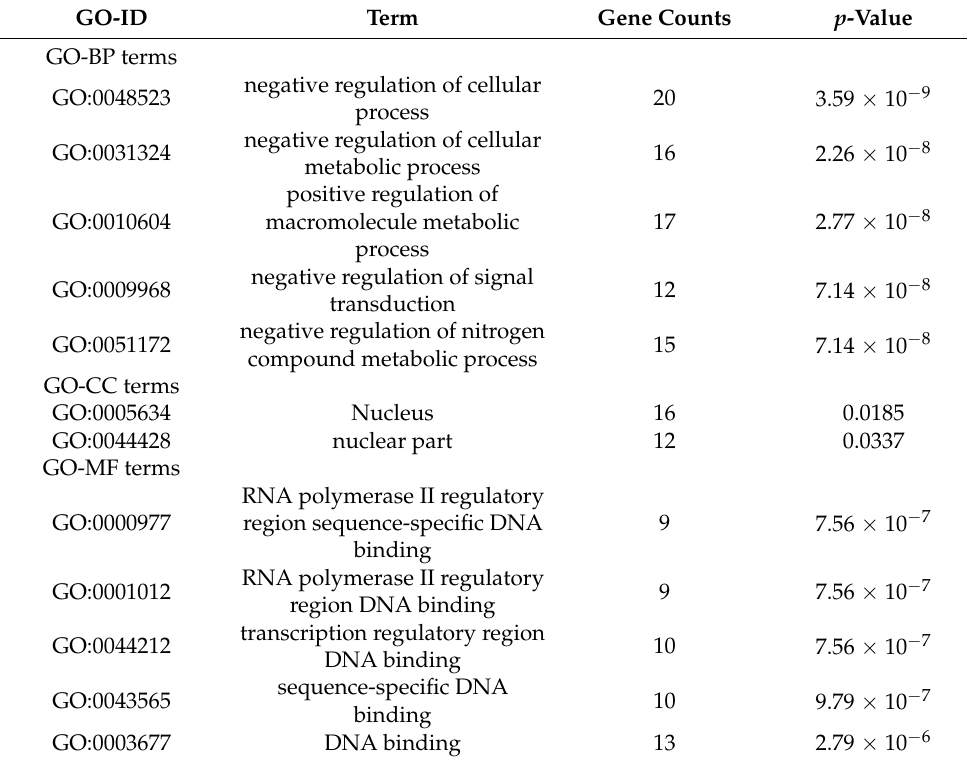
Figure 7. Module diagram of interaction network. Red and green represent genes from upregulation to downregulation. Table 4. Top 5 GO enrichment significance items in Module.